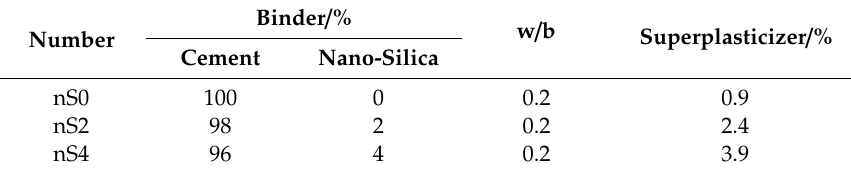
Table 2. Mix proportion design of ultra-high strength concrete